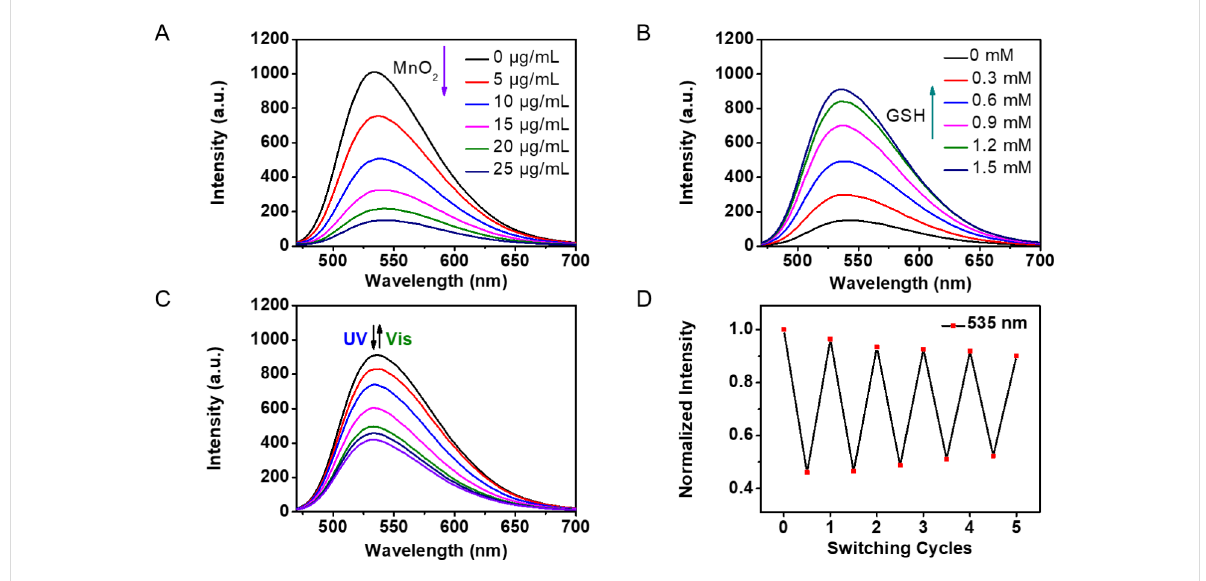
Figure 3: (A) Emission spectral changes of reporter Glyco-DTE (1 × 10 − 5 mol/L in PBS buffer, 0.25‰ Triton X-100) upon addition of 0–25 μ g/mL MnO 2 , (B) emission spectral changes of glycosheet upon addition of 0–1.5 mM GSH, (C) emission spectral changes and (D) fatigue resistance of reporter Glyco-DTE (after the degradation of MnO 2 with GSH) upon irradiation with UV (254 nm) and visible light (>500 nm). Emission spectra were produced upon excitation at 448